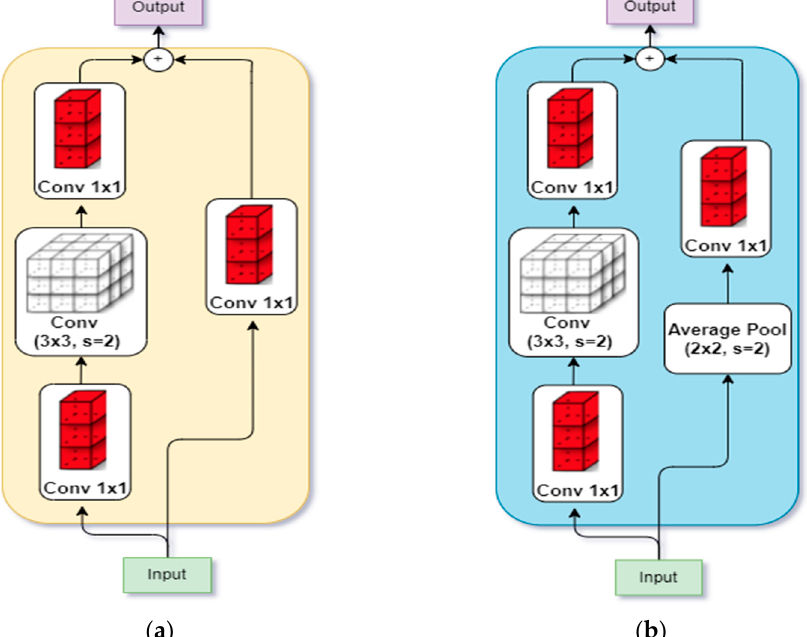
Figure 2. Architectural Modification by [13]. ( a ) Down-sampling in original ResNet [12]; ( b ) Down- sampling in XResnet [13].